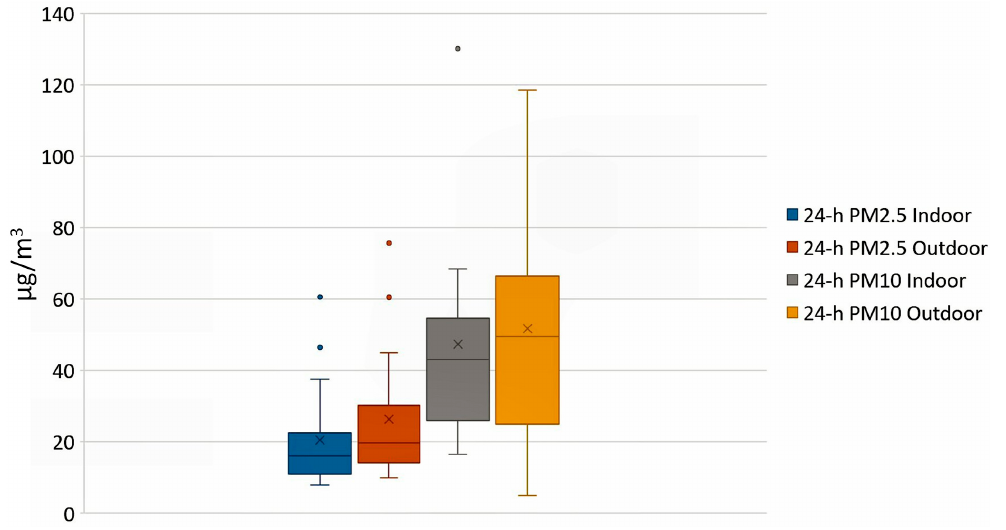
Figure 1. Box plot of 24 h-mean values of PM 10 and PM 2.5 [ μ g/m 3 ] in indoor and outdoor environments.